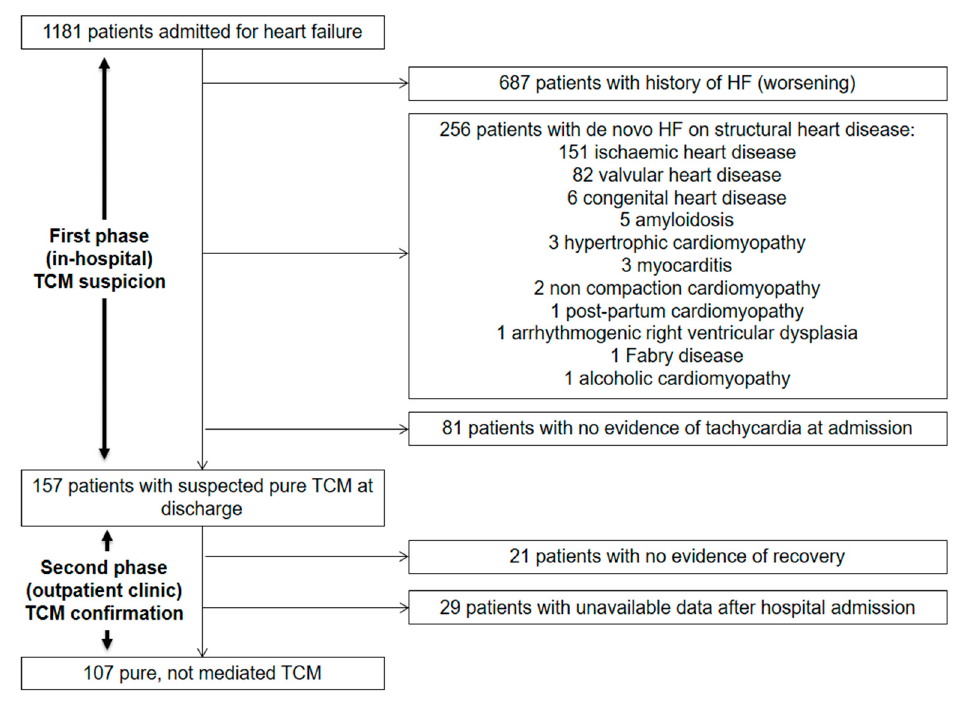
Figure 1. Selection process.